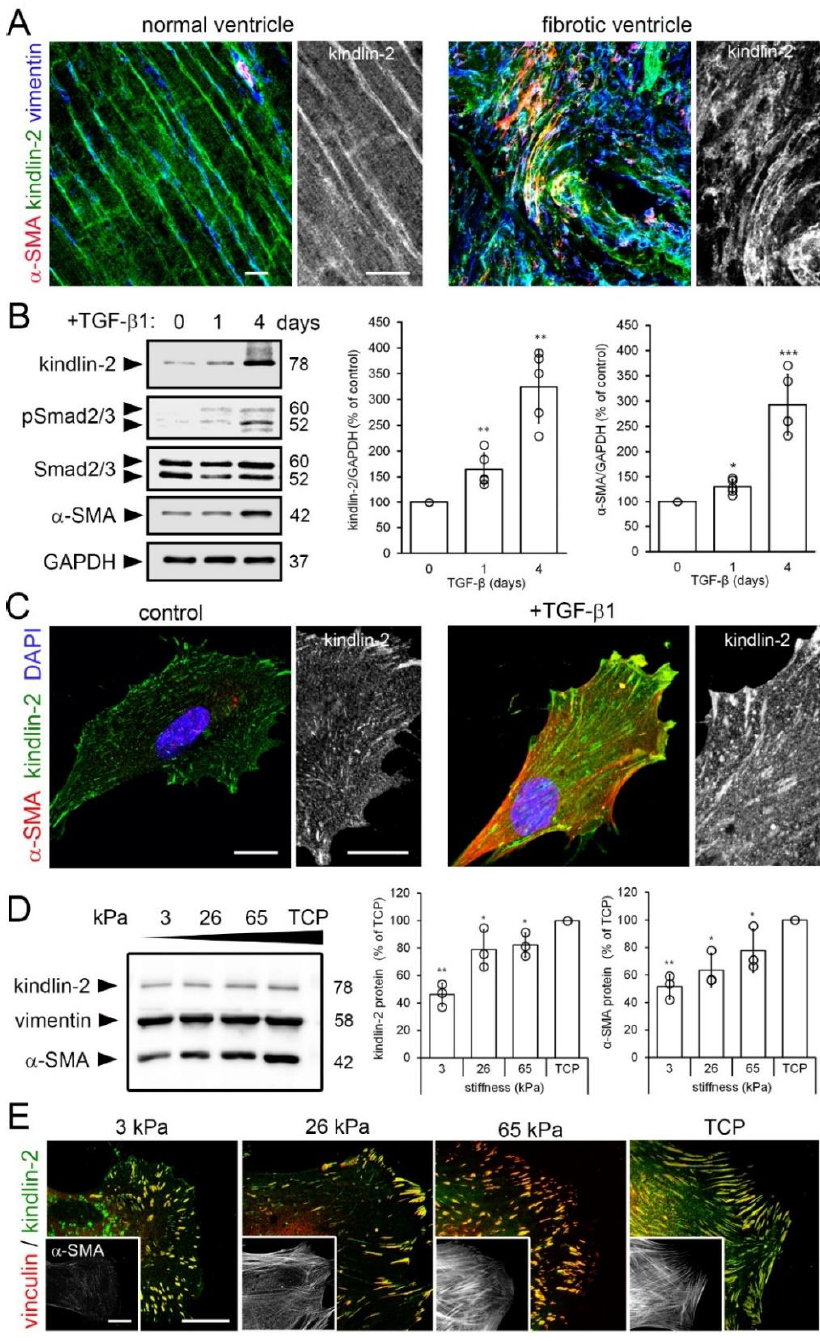
Figure 1. Kindlin-2 expression is enhanced in stiff mechanical environments in vivo and in vitro. ( A ) Sections of normal and hypertrophic rat hearts were stained for kindlin-2 (green), α -smooth muscle actin (α -SMA) (red), and vimentin (blue), and were observed with confocal microscopy; average intensity projections of z-stacks are displayed. Vimentin- and α -SMA-positive myofibroblasts in the hypertensive heart strongly express kindlin-2 in fibrotic lesions. ( B ) Human fibroblasts were cultured on tissue culture plastic (TCP) for 5 day and treated for 1–4 day with transforming growth factor (TGF)- β 1 (2 ng / mL) to assess expression of kindlin-2 and α -SMA by quantitative immunoblotting with indicated molecular weights. Glyceraldehyde 3-phosphate dehydrogenase (GAPDH) was used as loading control and Smad2 / 3 to assess TGF- β 1 downstream signaling. ( C ) After 4 day treatment with TGF- β 1, cells were immunostained for kindlin-2 (green), α -SMA (red), and nuclei (4 (cid:48) ,6-diamidino-2-phenylindole, DAPI, blue) and confocal images were taken. ( D , E ) Likewise, human cardiac fibroblasts (hCF) were